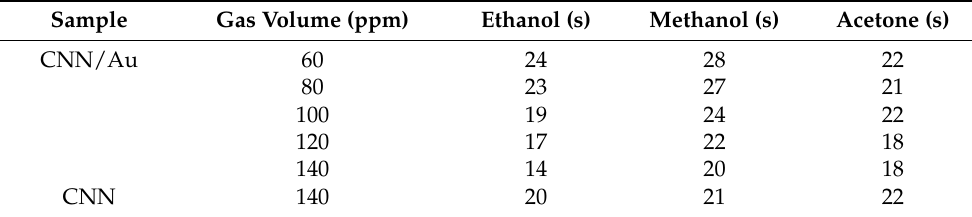
Table 3. The response moments of the CNN- and CNN/Au-centered sensor for different ppm of acetone, methanol, and